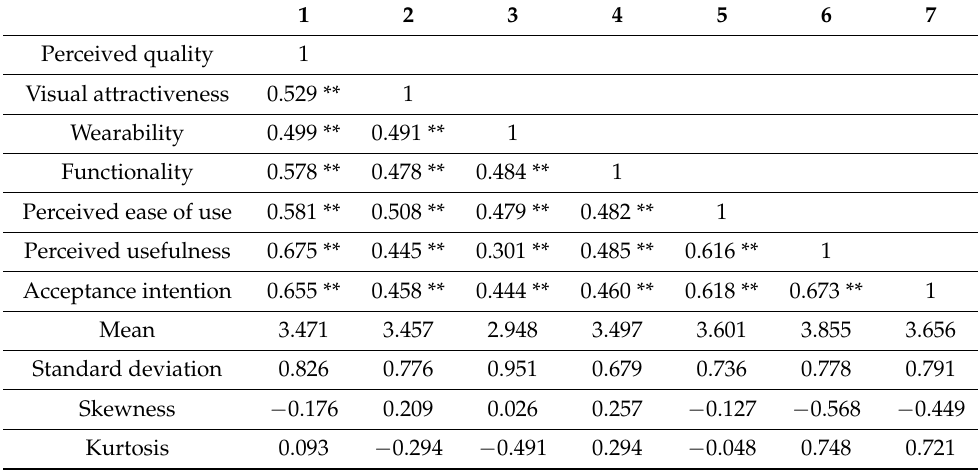
Table 3. Correlation analysis and normality of